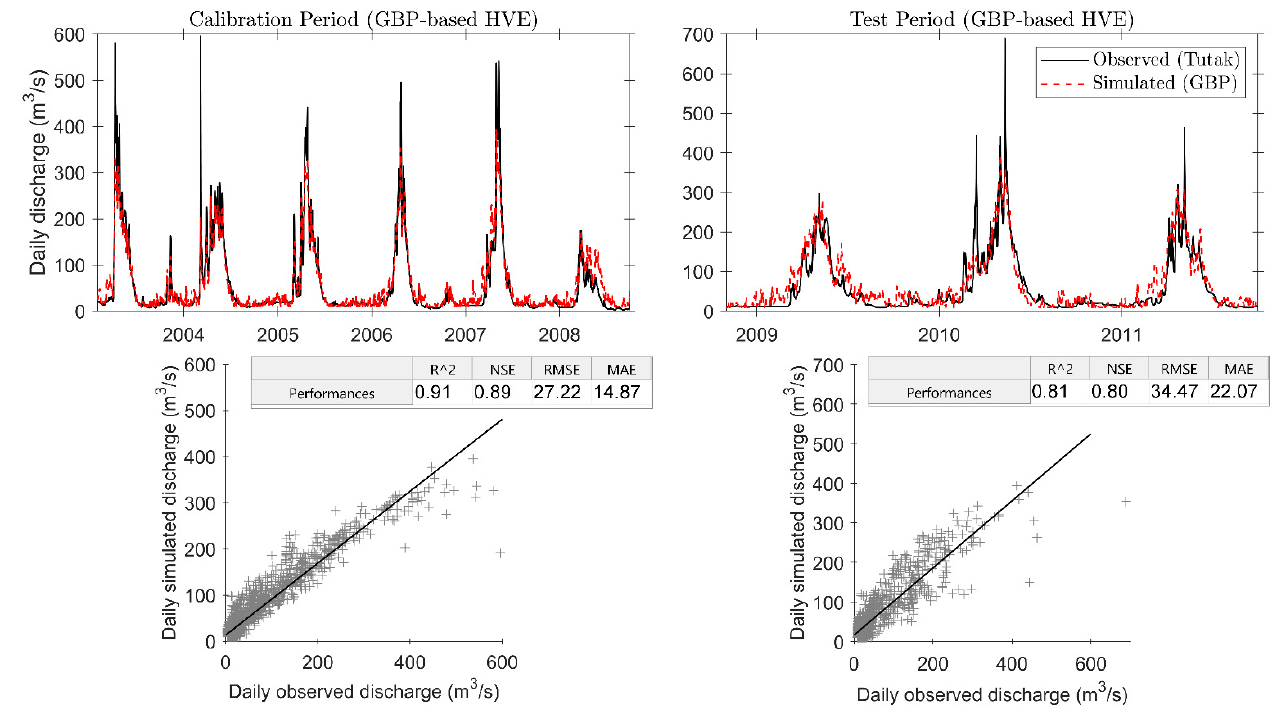
Figure 9. HVE results using Agri station GBP